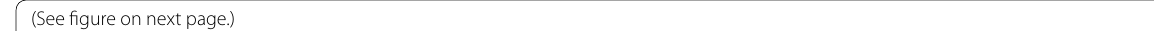
slide for 4 runs (slide